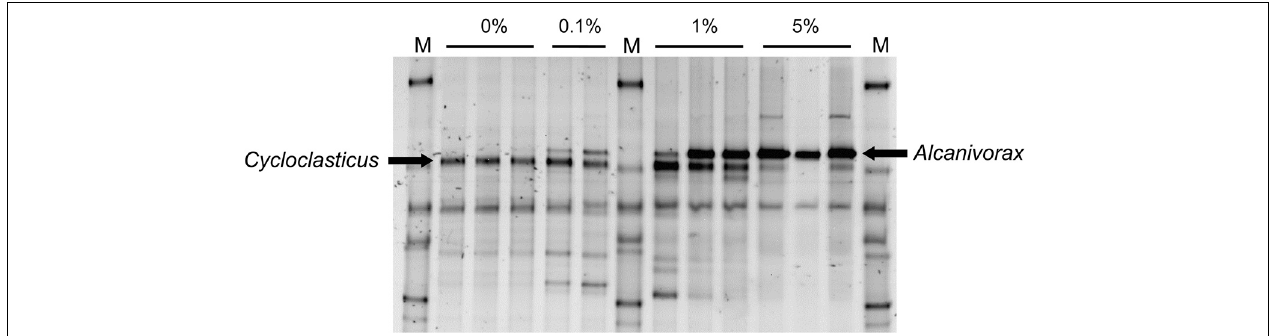
FIGURE 7 | Denaturing gradient gel electrophoresis of 16S rRNA gene fragments from crude oil and nutrient treated beach microcosms incubated for 6 days. Fragments corresponding to Cycloclasticus spp and